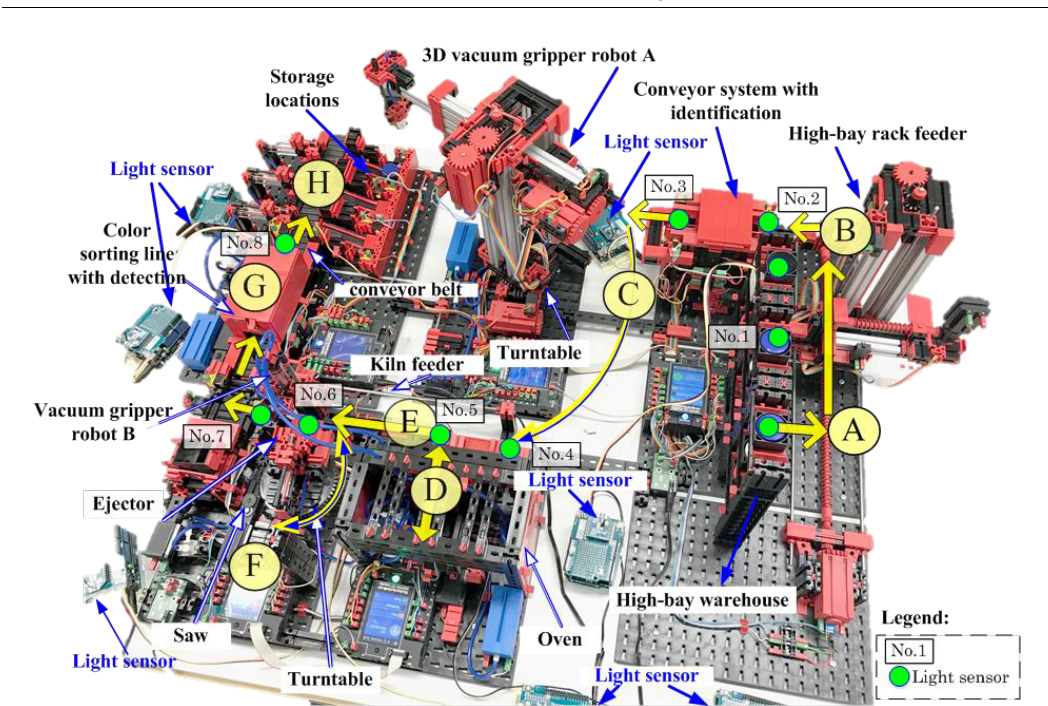
Figure 5. Overhead view and the sequence of processes of the factory model.